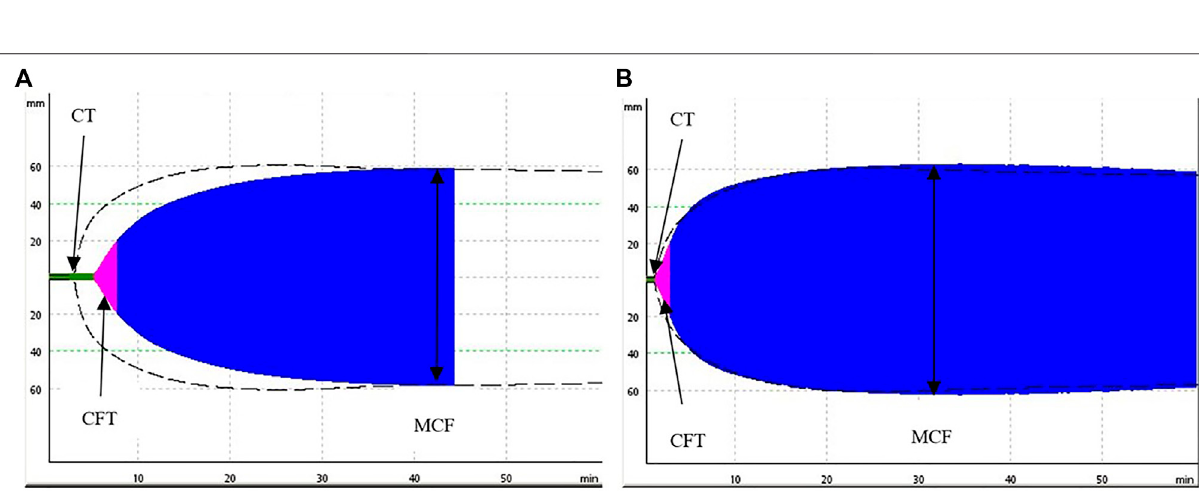
FIGURE 2 | Comparison of two representative ROTEM (ExTEM) tracings measured at 13.7 ° C (A) and at 37 ° C (B) . The (A) demonstrates a prolongation of the coagulation time (initiation of the clot) and of the clot formation time (propagation of the clot) when compared to a normal clot formation on the (B) , the maximum clot fi rmness (stiffness of the clot) is